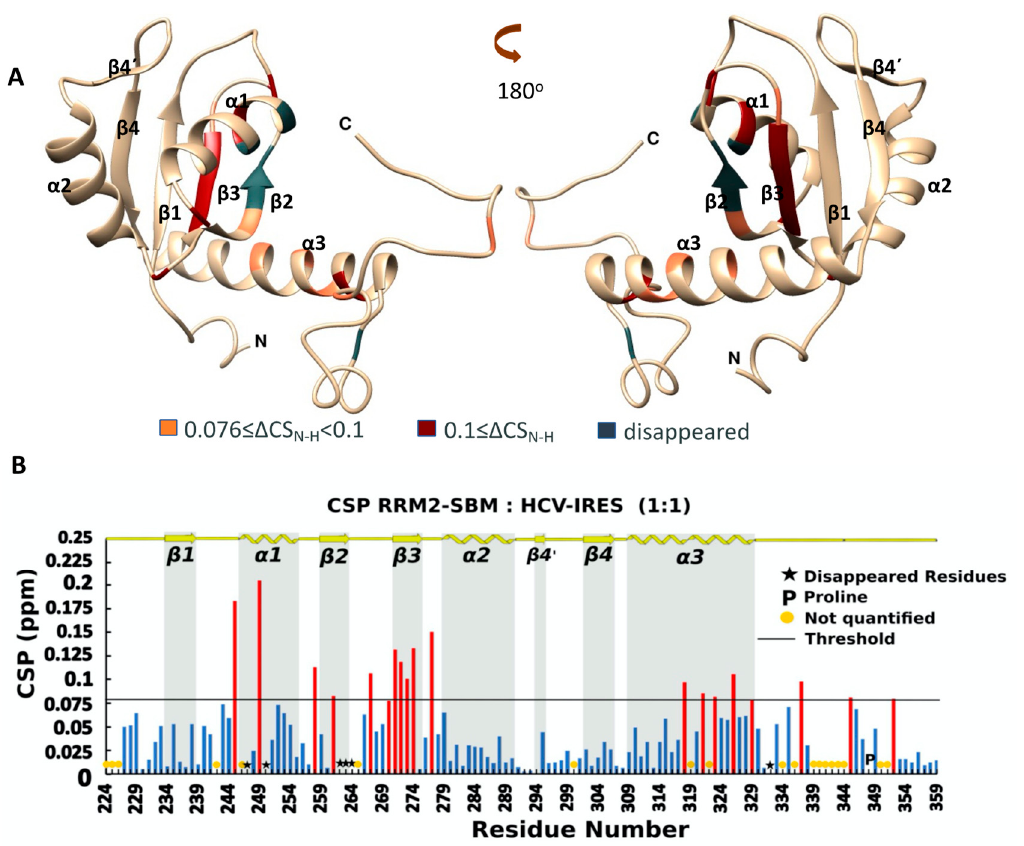
Figure 3. ( A ) Ribbon representation of the affected amino acids mapped into the hRRM2-SBM structure; ( B ) chemical shift perturbation of 15 N-hRRM2-SBM upon the addition of the unlabeled ligand in threshold value 0.076. Red bars indicate CSPs above threshold, while blue bars illustrate CSPs beyond threshold line.